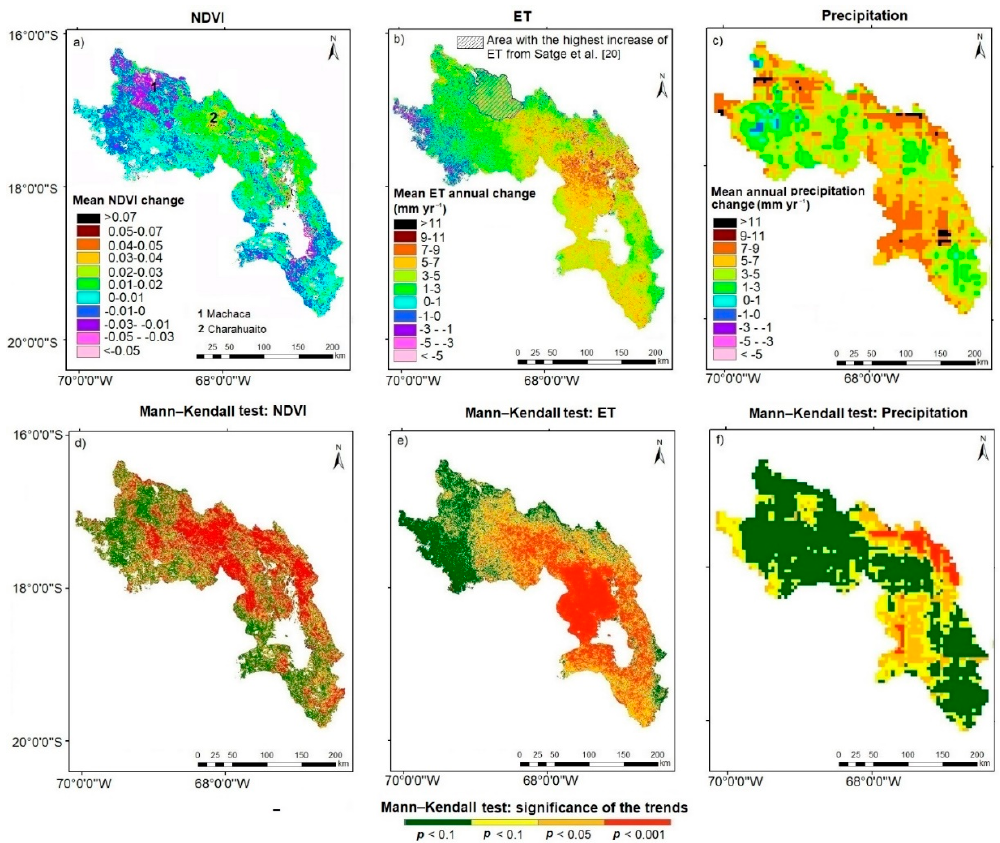
Figure 5. Spatial distribution of NDVI, ET and precipitation trends during the study period: ( a ) Mean NDVI change (calculated as the mean trend multiplied by the duration of the study period); ( b ) Mean ET trend; ( c ) Mean precipitation trends. ( d – f ) show the spatial distribution of the significance level of the trends for the period 2002–2014 in the DP system. Red, orange and yellow colours indicate significant results.